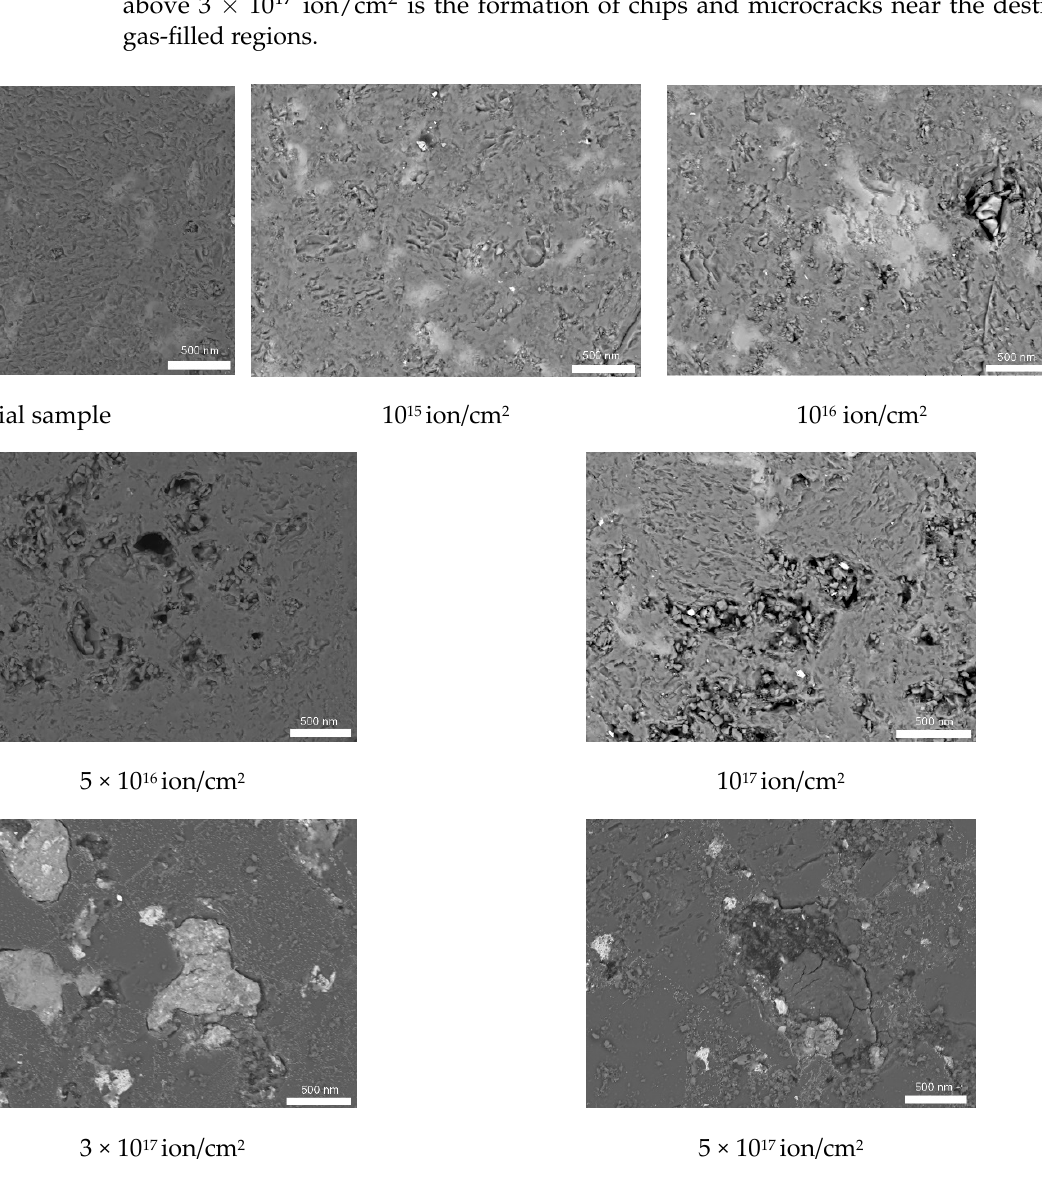
Figure 12. Results of morphological changes in the surface of SiC ceramics depending on irradia- tion fluence.